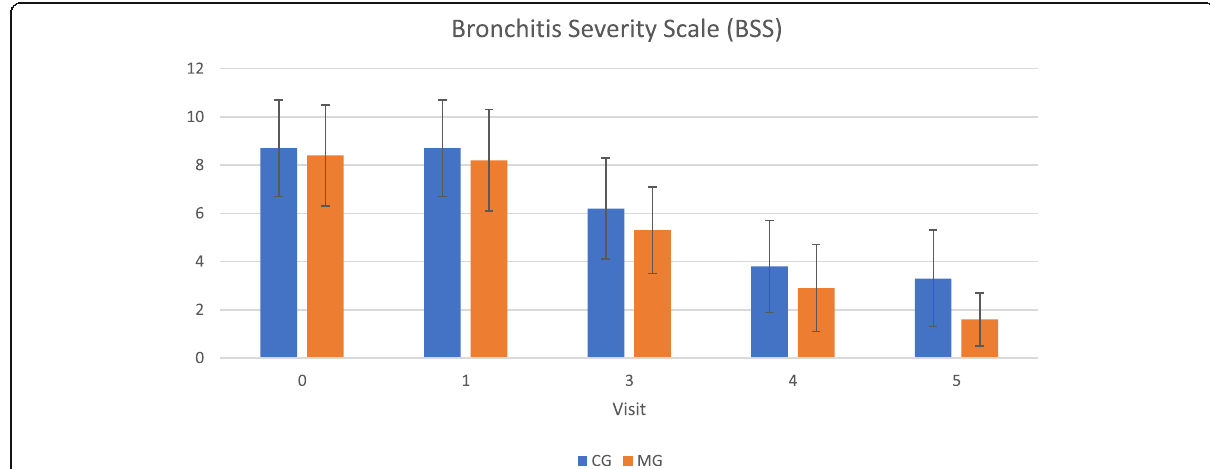
Fig. 3 Mean of the scores in CG (control group = standard antiviral): visit 0 = 8.7 SD(2.0), visit 1 = 8.7 SD(2.0), visit 3 = 6.2 SD(2.1), visit 4 = 3.8 SD(1.9), visit 5 = 3.3 SD(2.0). Mean of the scores in MG (main group = standard antiviral + cineole): visit 0 = 8.4 SD(2.1), visit 1 = 8.2 SD(2.1), visit 3 = 5.3 SD(1.8), visit 4 = 2.9 SD(1.8), visit 5 = 1.6 SD(1.1).). From visit 3 onward, there was a statistically significant difference in favor of the Cineole group in the BSS total score ( p < 0.05)